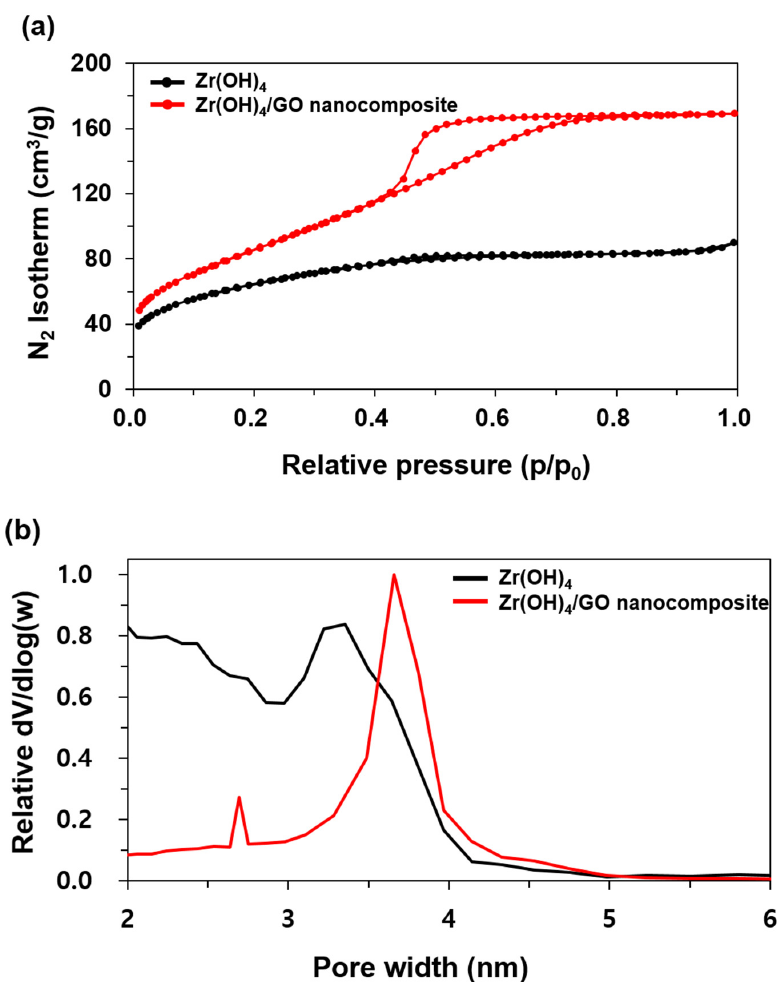
Figure 2. ( a ) N 2 gas adsorption-desorption isotherms at 77 K and ( b ) pore size distribution for